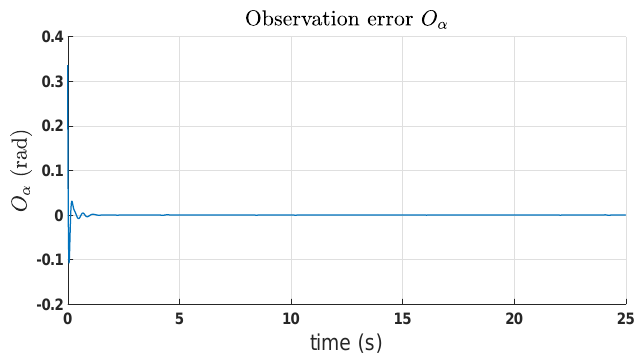
Figure 13. Observation error dynamics O α .